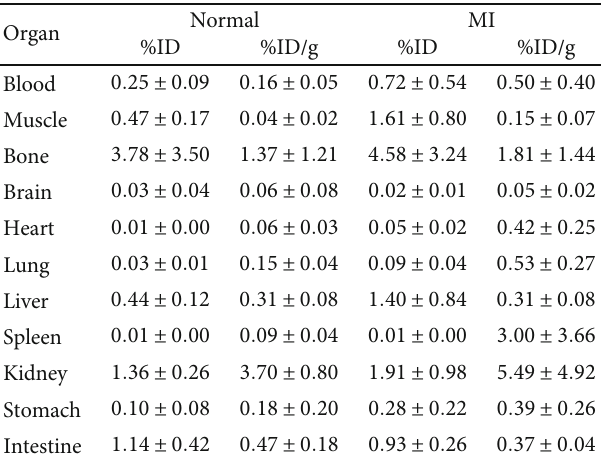
Table 1: Biodistribution of 18 F-FGA in normal and MI mice after 1h of injection ( mean + SD ; n = 6 /group).